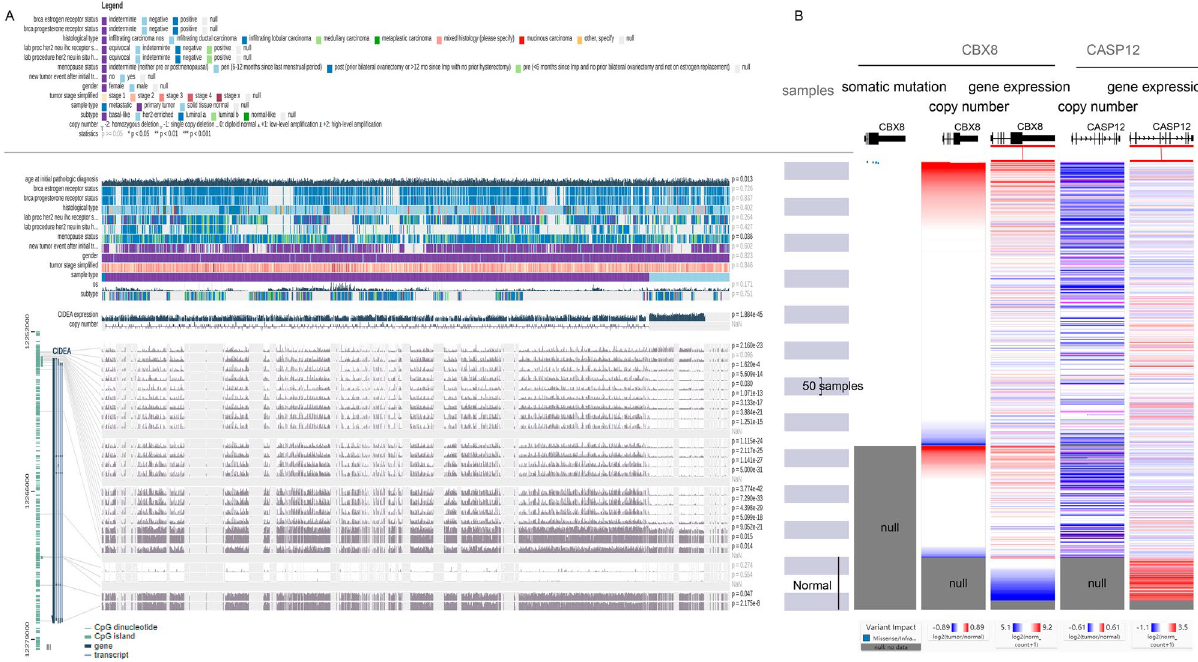
Figure 1. Genetic alteration and gene expression alteration of CIDEA , CBX8 and CASP12 in BRCA. ( A ) DNA methylation and expression data for the gene CIDEA in breast cancer. The DNA methylation data are plotted for each probe separately and the data is linked to the genomic location of the probe. A chi-squared test was used to compare if there was a difference in the methylation distribution between normal and tumor samples. The samples are ordered by the sample type using MEXPRESS. ( B ) Genetic alteration and gene expression alteration of CBX8 and CASP12 using UCSC